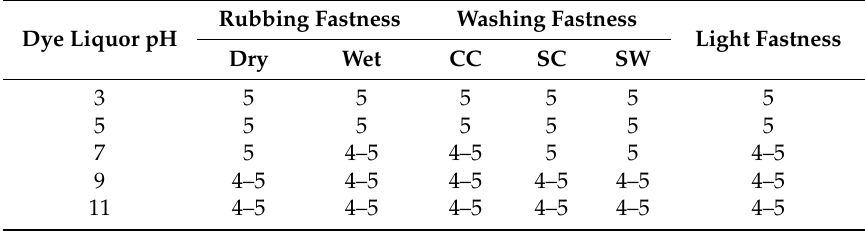
Table 8. The color fastness of dyed wool fabrics based on catalytic oxidation with laccase.